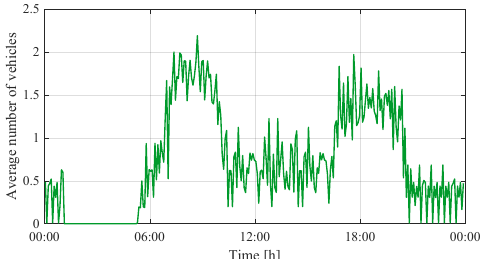
Figure 13. Number of trolleybuses operating in FS MTT in function of the time (5 min averaged). The plot covers a 24-h simulation